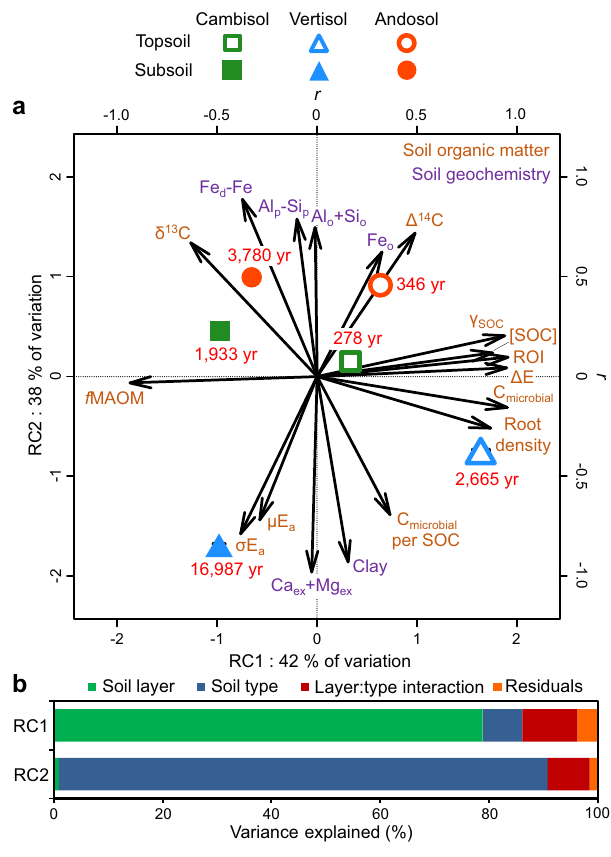
Fig.1|Variationinsoilbiogeochemicalpropertiesamongsoiltypesandlayers. a ordination by rotated principal component analysis ( n =24 soil cores). Arrows indicate correlations between soil properties and rotated component (RC) axes. Large symbols with error bars show treatment means±standard errors. The numbers in red indicate the turnover time of soil organic carbon (SOC) based on radiocarbon signature for each treatment. The subscripts ex , d , o , and p indicate exchangeable, dithionite, oxalate, and pyrophosphate extracts, respectively. See Table 1 for other abbreviations. b variance partitioning of RC axis values across experimental